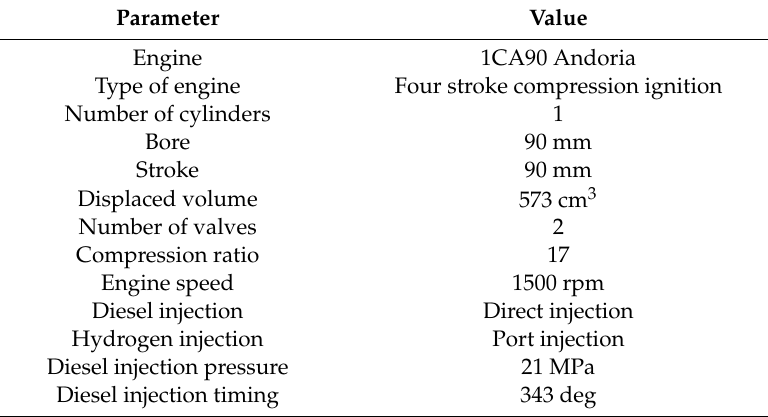
Table 1. Main engine parameters.